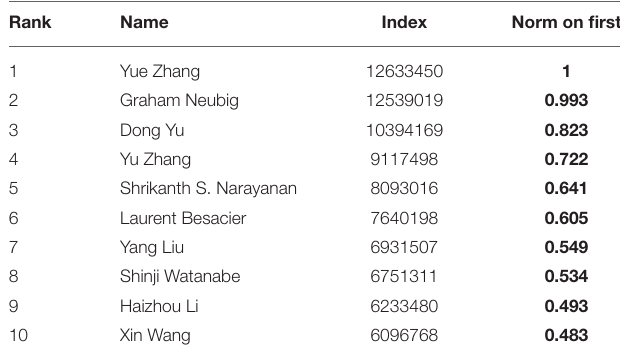
TABLE 10 | Closeness centrality for the 10 most central authors in the past 5 years (2016–2020).